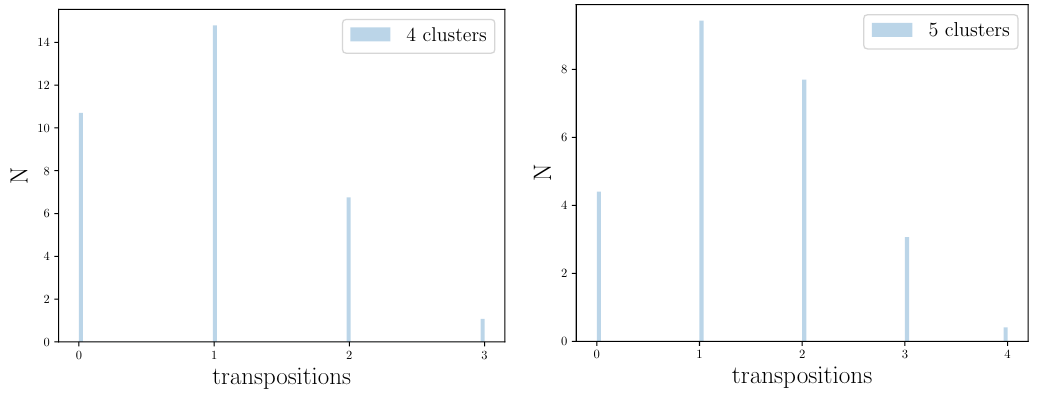
Figure 13 . Number of transpositions between the initial state and the reconnected (cid:12)nal state for four and (cid:12)ve cluster evolution.